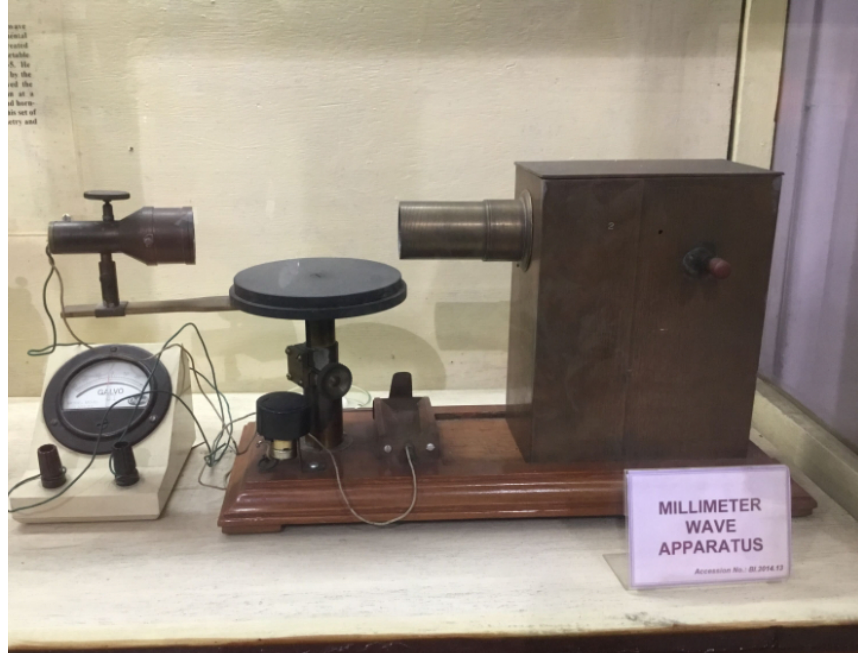
Figure 1a: Millimeter-wave apparatus manufactured by J. C. Bose. Photographed by the author at the Bose Museum, Kolkata.